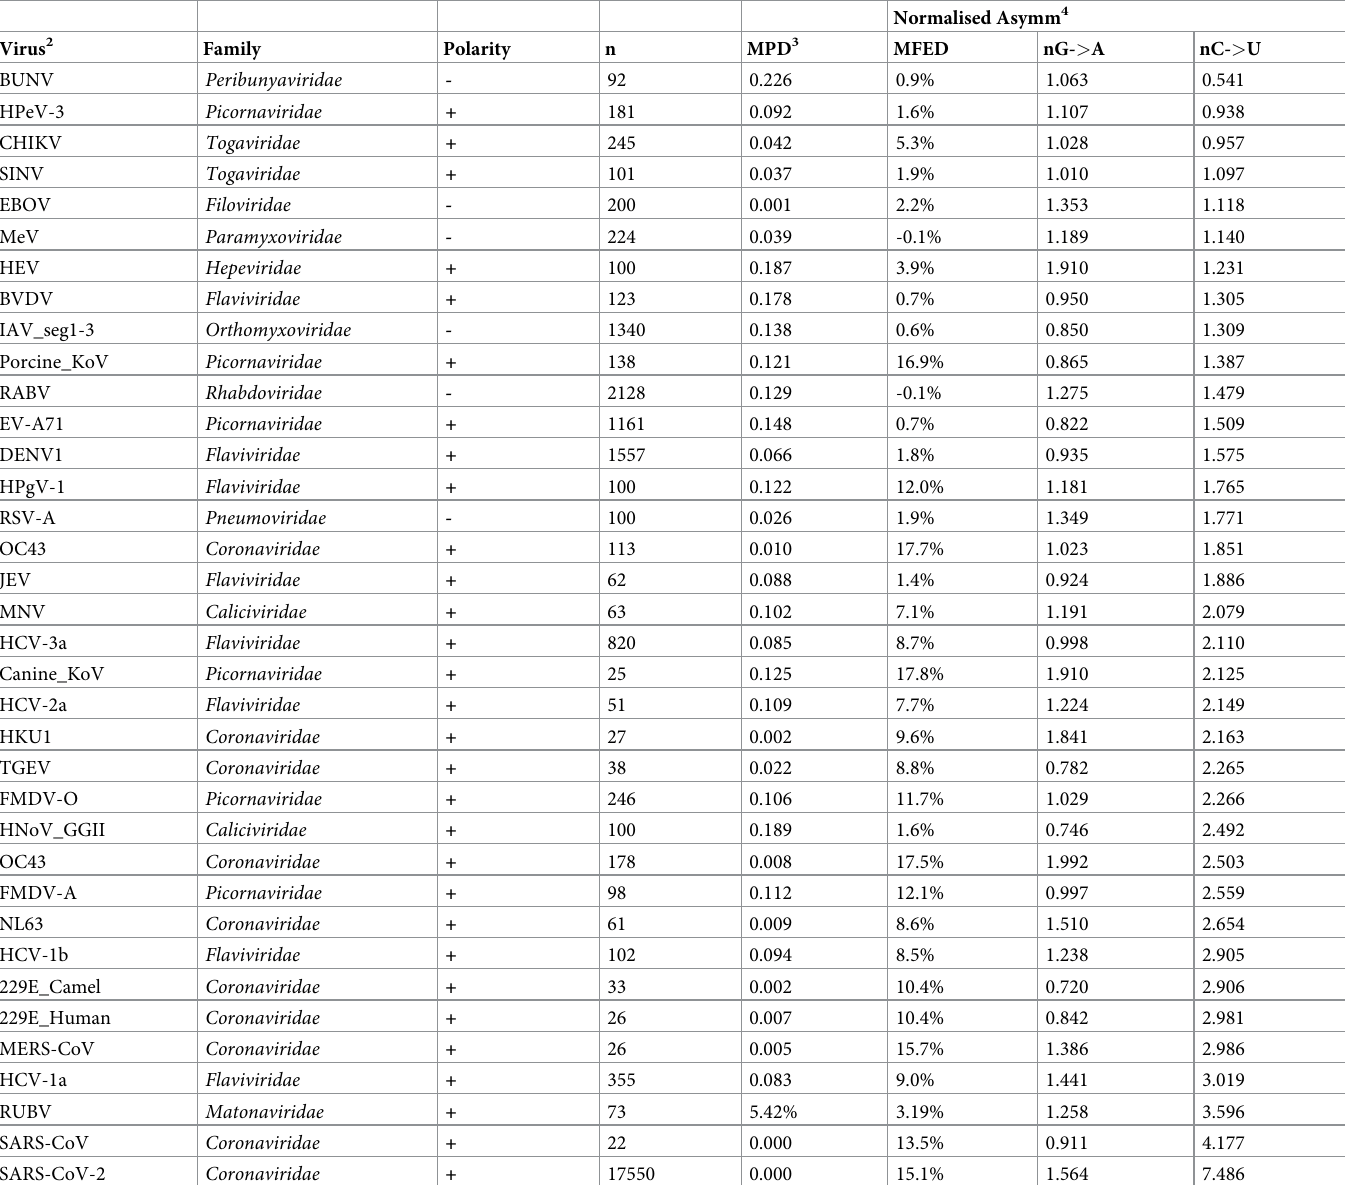
Table 1. COMPOSITIONAL FEATURES OF RNA VIRUS SEQUENCE DATASETS USED IN THE STUDY 1